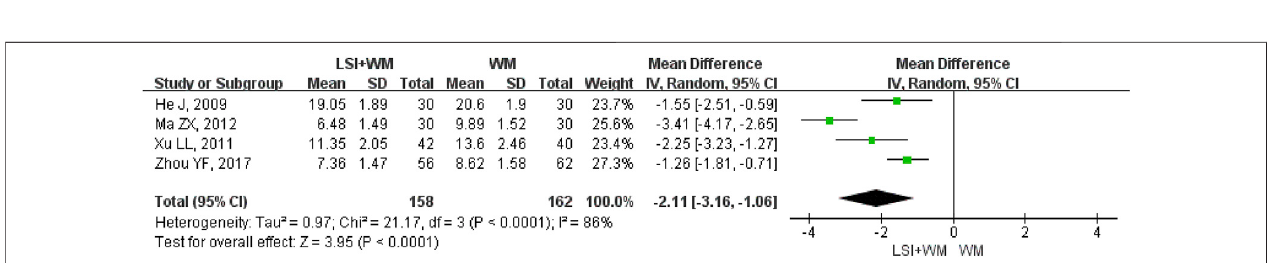
FIGURE 6 | Forest plot of LBV of ligustrazine injection in treating ACI. LSI is ligustrazine injection and WM is Western medicine.